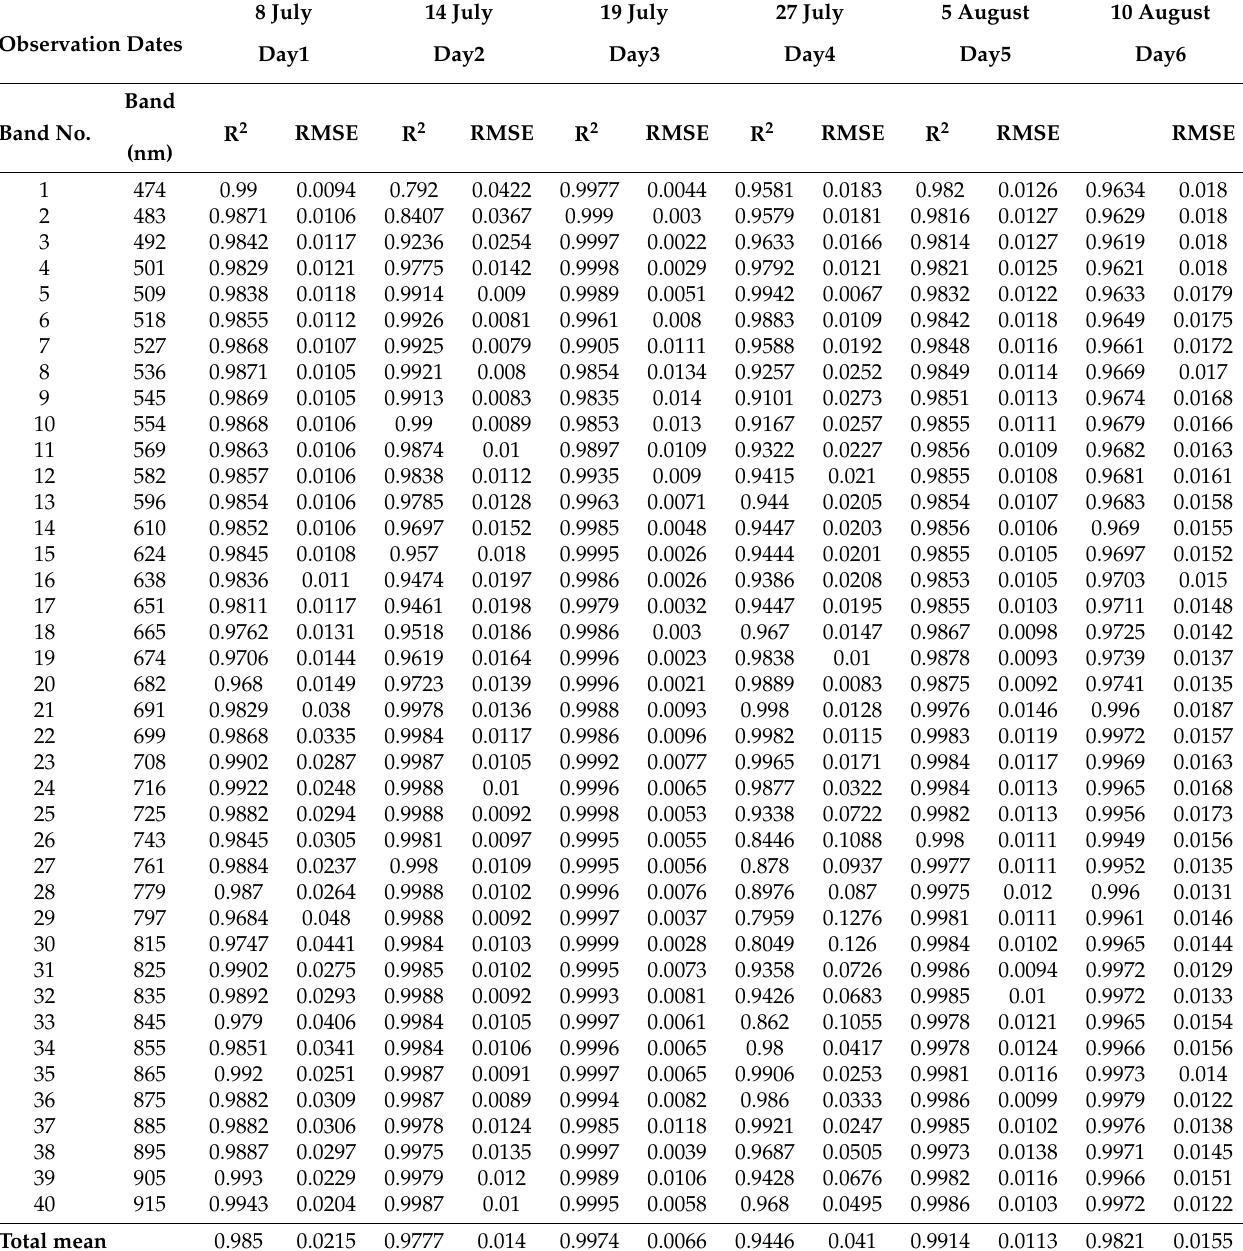
Table A1. Radiometric accuracies across bands per date of the ELC for hyperspectral UAV orthomosaics.